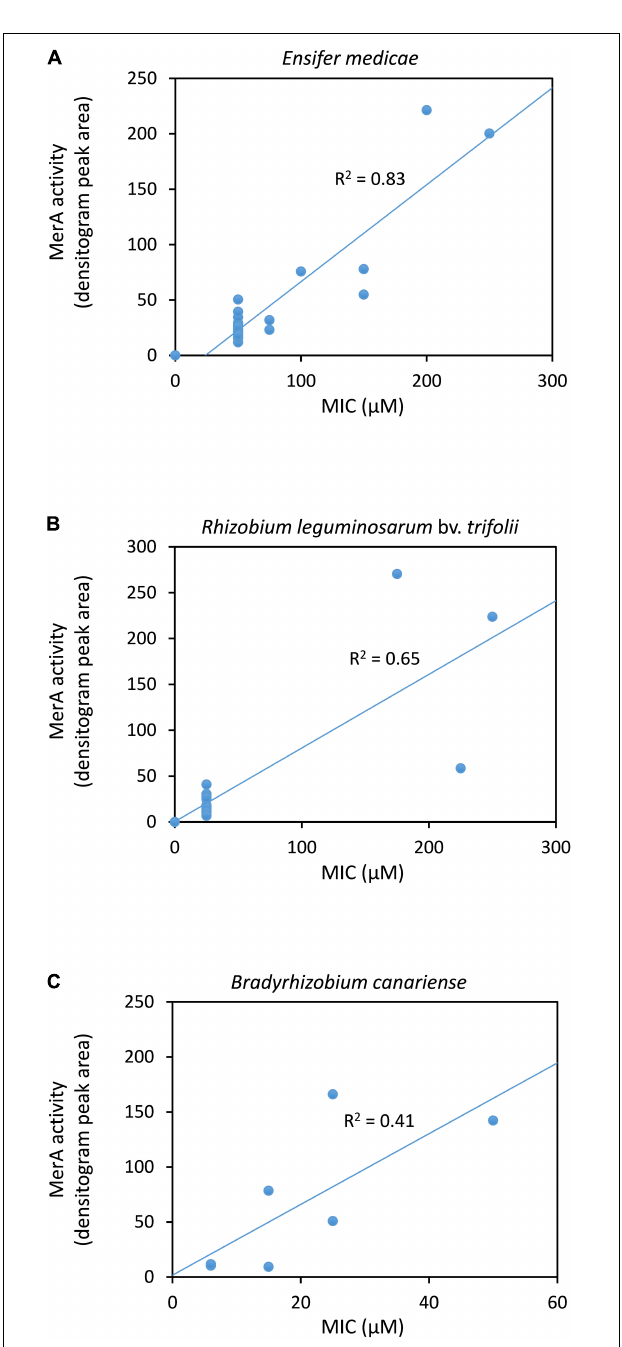
FIGURE 1 | Correlation between mercuric reductase activity and mercury tolerance of rhizobial strains. (A) Ensifer medicae . (B) Rhizobium leguminosarum bv. trifolii. (C) Bradyrhizobium canariense . Mercuric reductase values were obtained from the densitometry analyses of the X-ray films. The coefficients of determination R 2 are